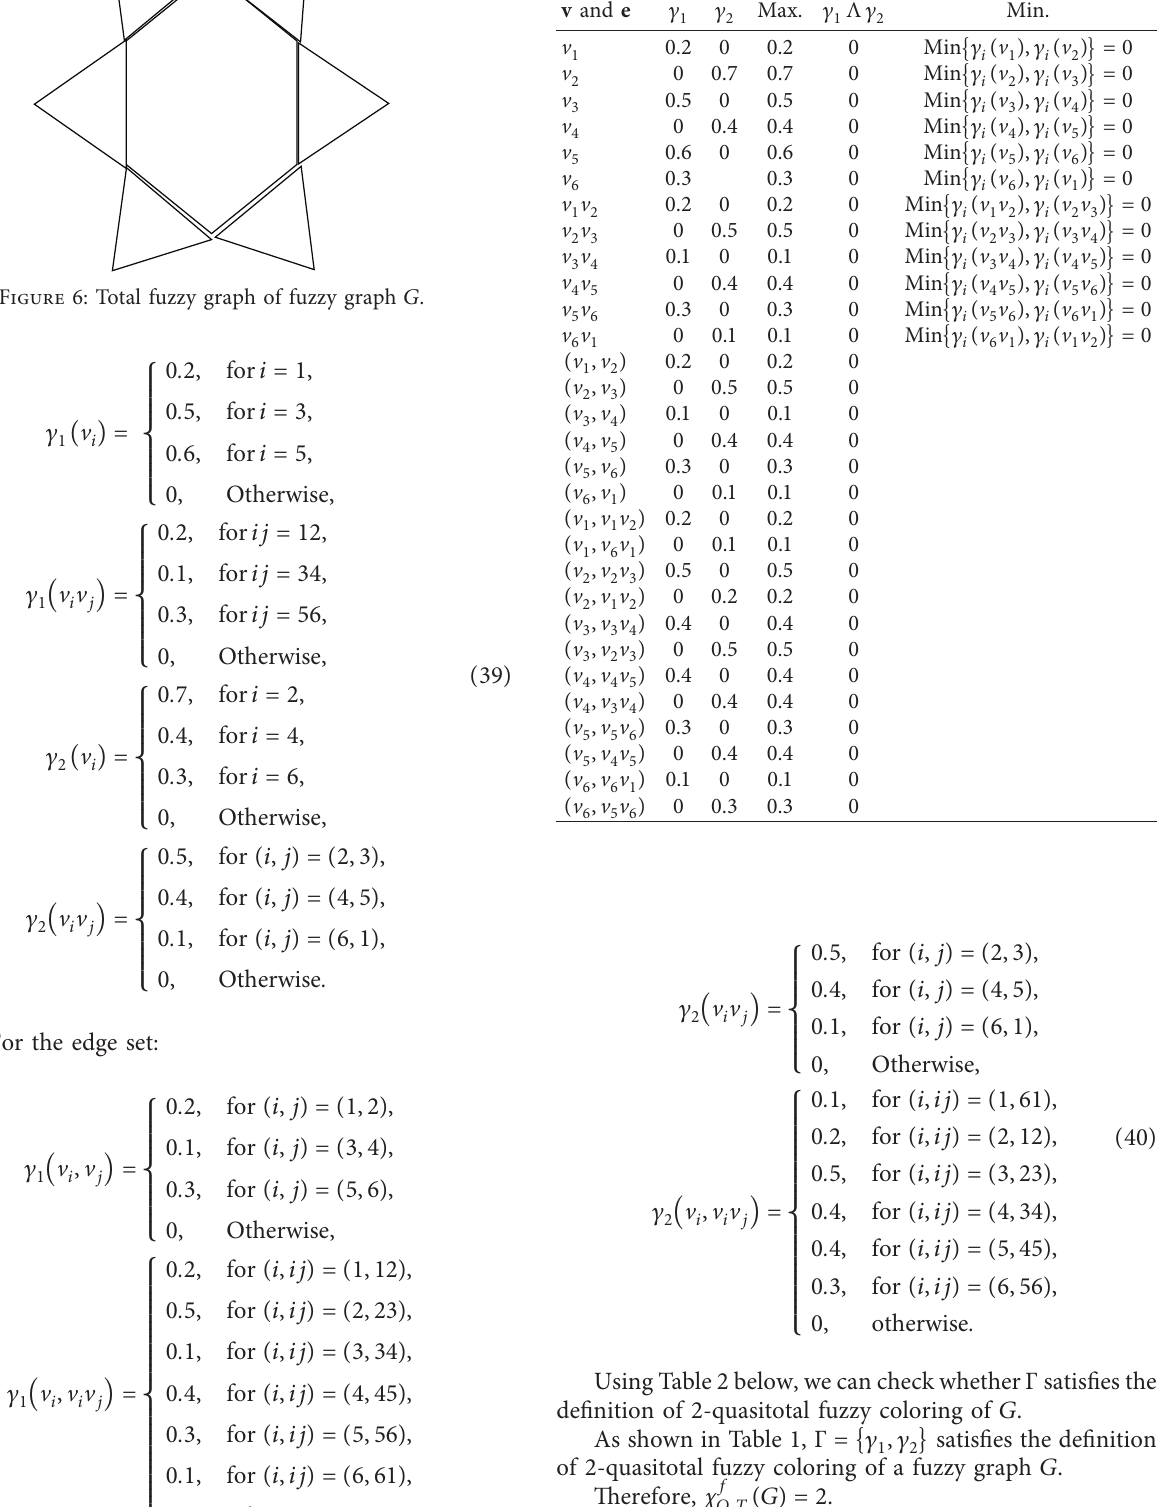
Table 2: Example of 2-quasitotal coloring of a fuzzy graph G � ( V, σ , μ ) v and